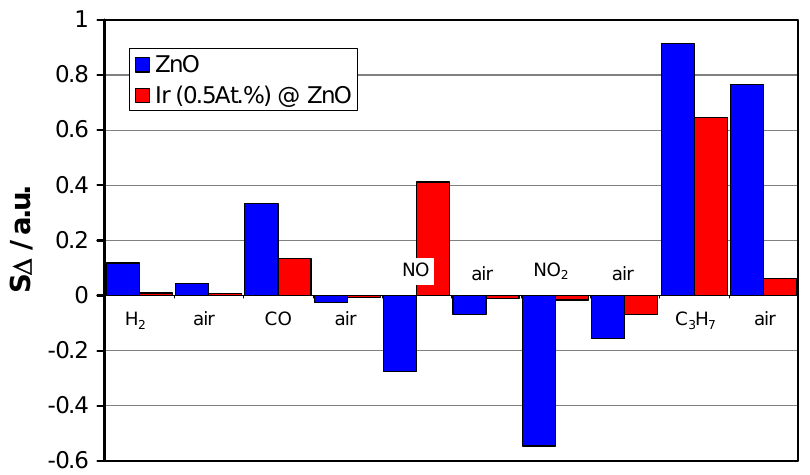
Figure 7. Relative sensitivity of undoped (blue) and iridium doped (red) zinc oxide (T = 300 °C). The temperature dependence of the sensitivity S ZnO, is depicted in Figure 8. In addition, the temperature dependence of S In O is shown. 2 3